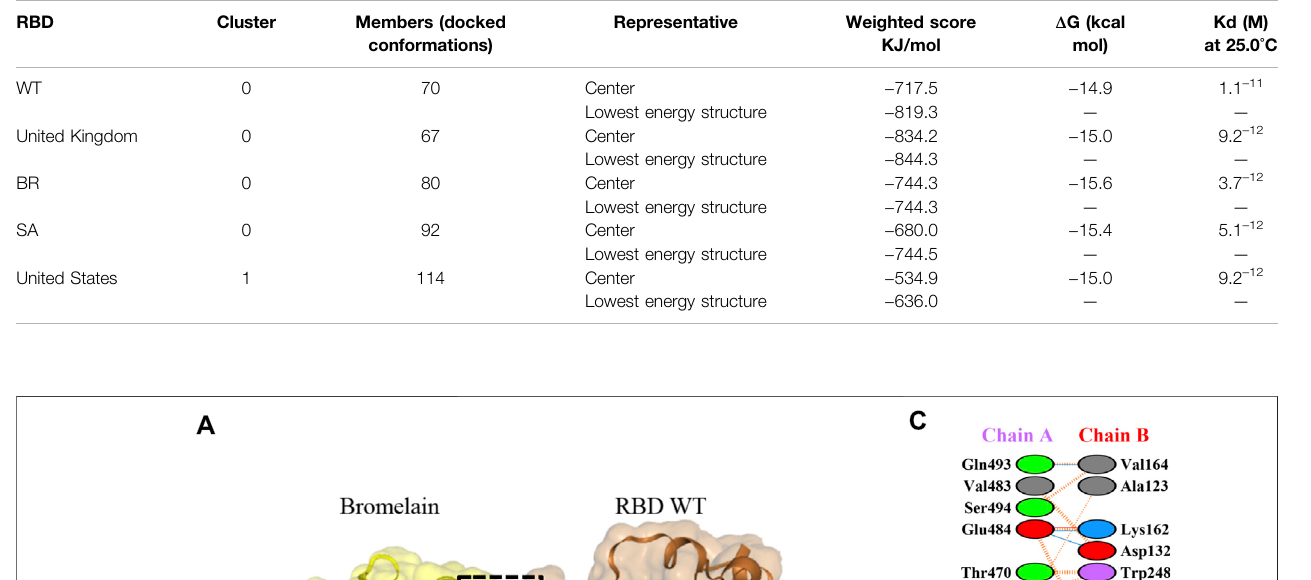
Frontiers in Pharmacology |